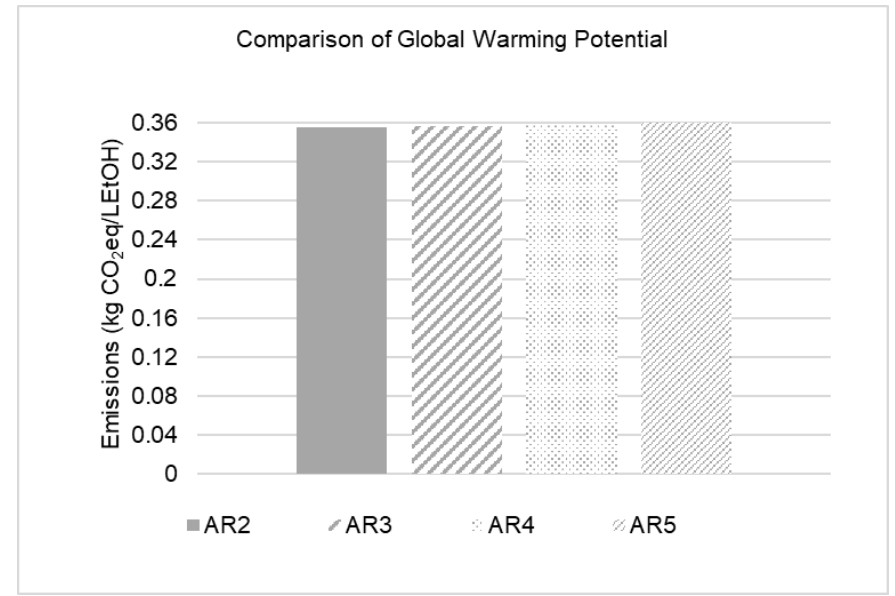
Figure 4. Comparison of GWP, using different values for CO 2 eq, considered in the referenced IPCC ARs, for 100 years.